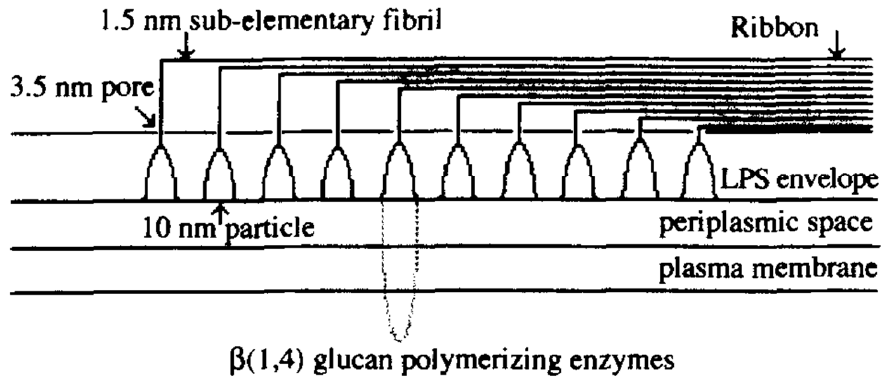
Figure 5. Scheme for the formation of bacterial cellulose (adapted from [4], with permission from © 1998 Elsevier).